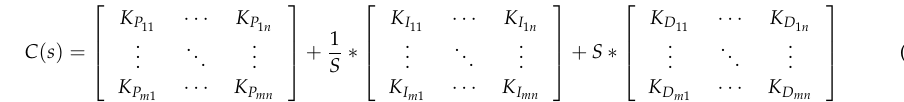
Figure 8. A closed-loop system with the PID H ∞ controller using the ABC algorithm. n is the number of inputs, m is the number of outputs, D(t) is an external disturbance, N(t) is a noise signal, R(t) is a reference input, e(t) is an error signal of the closed-loop control system, and Yp(t) is the output system. The tuning algorithm of the PID controller C(s) can be presented as in Equation (6).